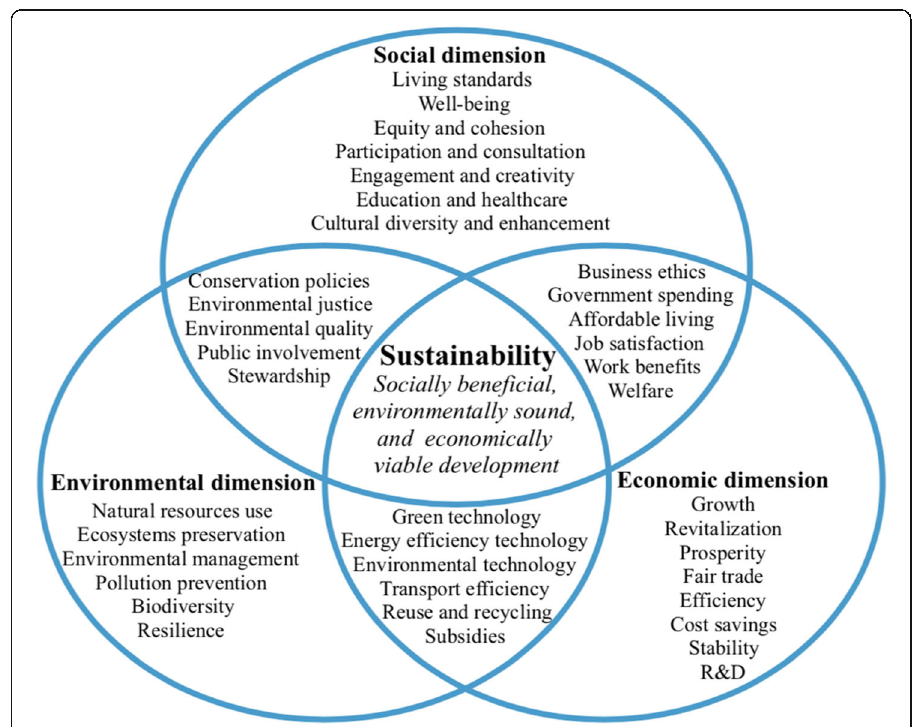
Fig. 2 A framework for balancing the three dimensions of